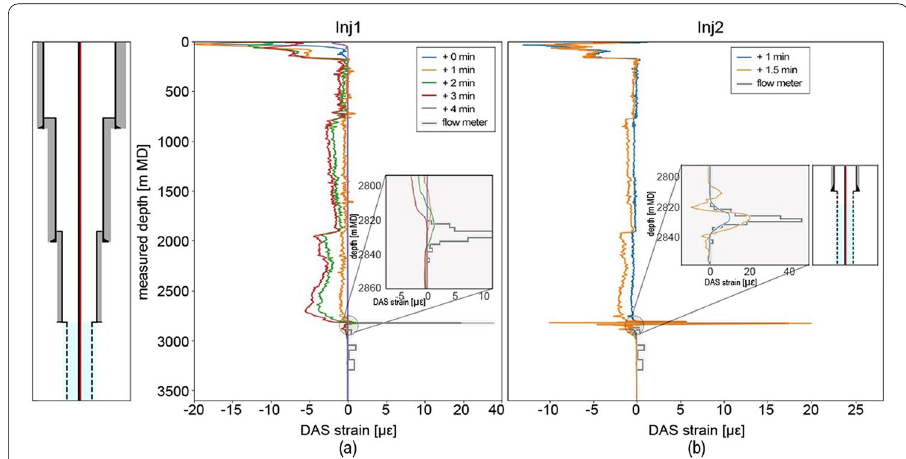
Fig. 8 DAS strain measurements at the beginning of injection tests Inj1 ( a ) and Inj2 ( b ). The gray line marks the injection profile from flowmeter. DAS strain at the top of the reservoir is given in zoomed in sub plots